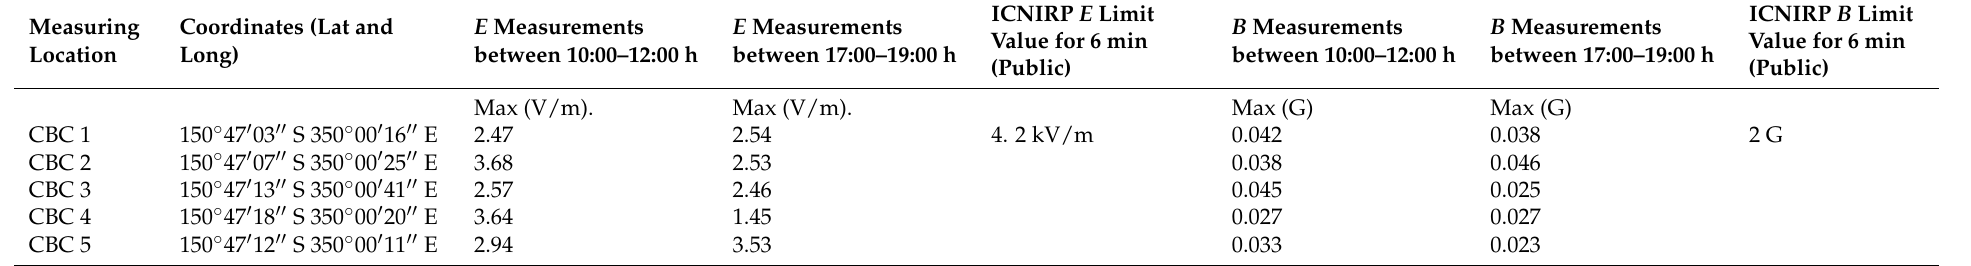
Table 9. Statistical results of E and B Blantyre